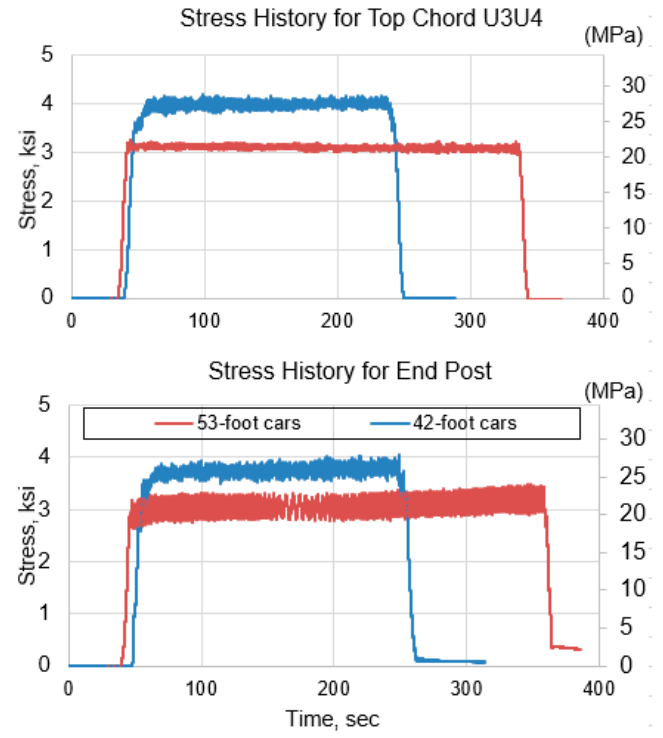
Figure 10. Stress histories calculated from measured strains in 61 ‐ m (200 ‐ ft) span: top chord (top) and end post (bottom).